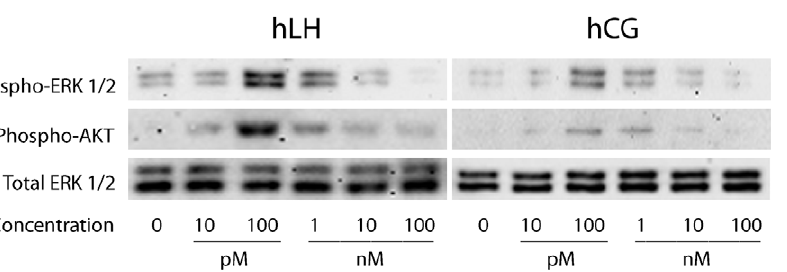
Figure 5. Dose-response experiment evaluating the maximal phospho-ERK1/2 and phospho-AKT activation in hGLC by Western blotting. The cells were stimulated for 15 minutes by different r-hLH or r-hCG doses and the phospho-ERK1/2 and phospho-AKT signals were normalized for total ERK. The image is representative of 3 independent experiments.